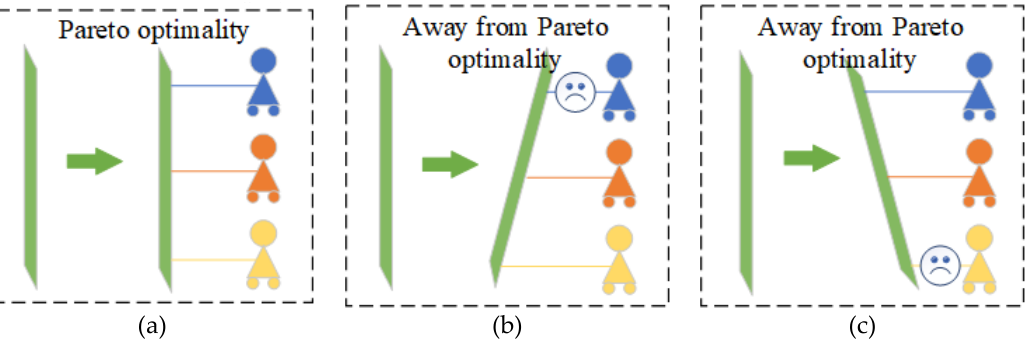
Figure 5. Pareto optimality, ( a ) an example of Pareto optimality; ( b ) an example of deviating from Pareto optimality; ( c ) another example of deviating from Pareto optimality.